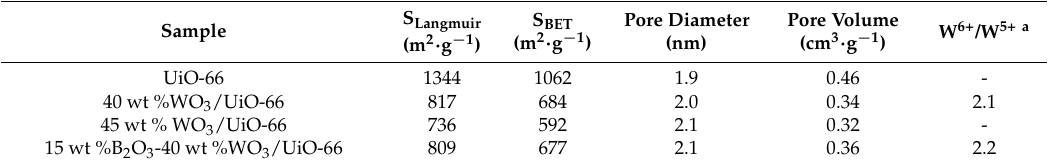
Table 1. Physico-chemical parameters of various samples.